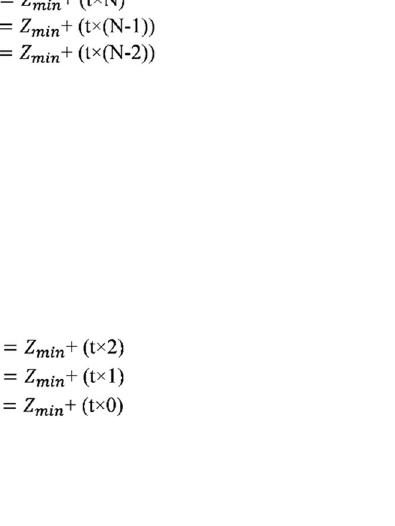
Figure 7. Horizontal slicing of a